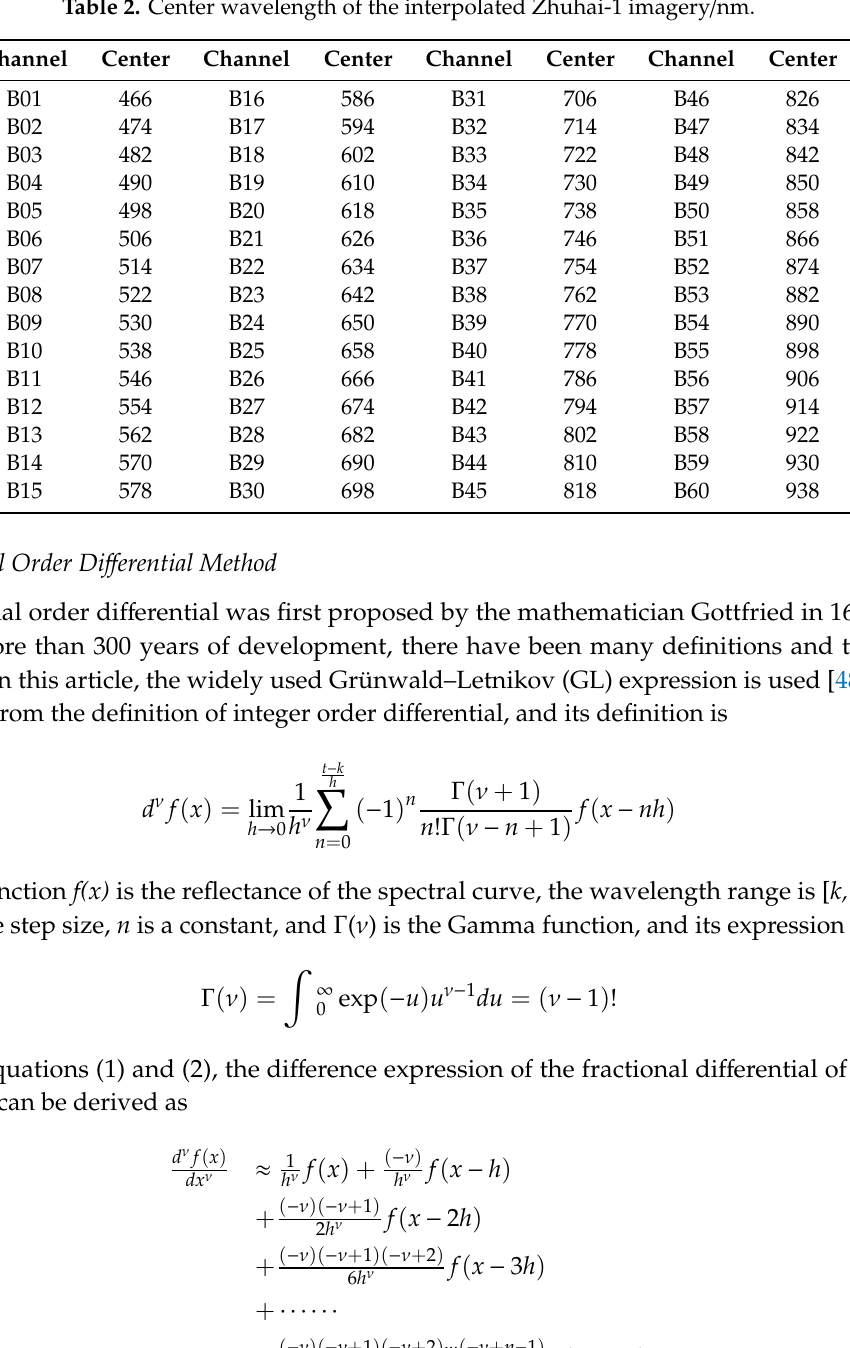
Table 2. Center wavelength of the interpolated Zhuhai-1 imagery /